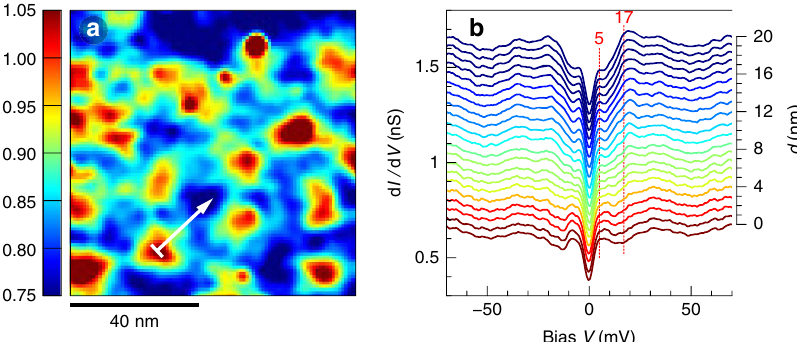
Figure 2 | The subgap states exist inside and outside vortices. ( a ) Ratio s SGS / s SC of the conductances at 5 and 17meV measured at T ¼ 0.4K in a 6 T field over a 90 (cid:3) 90nm 2 area. The vortex cores appear in red and the inter-vortex regions in blue. The white arrow indicates a 20-nm path starting in a vortex core. ( b ) Conductance spectra along the white arrow shown in a . The spectra are coloured according to the conductance ratio s SGS / s SC . The conductance scale is shown for the bottom spectrum; the others are displaced vertically by 0.05nS for visibility. The distance d to the core is shown on the right axis. The red dashed lines mark the energies 5 and 17meV.